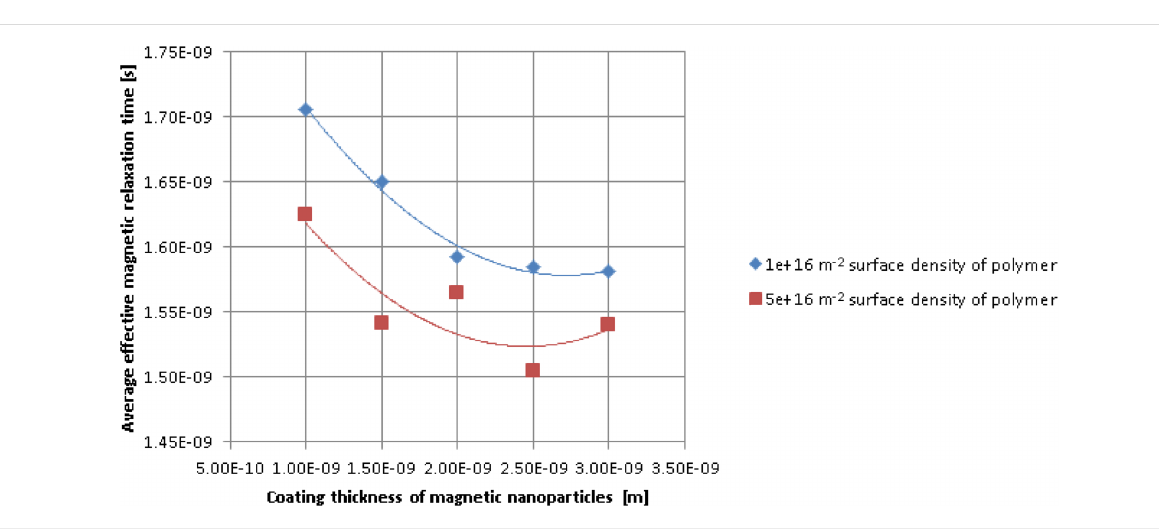
5 × 10 16 m − 2 ), the average value of the effective magnetic